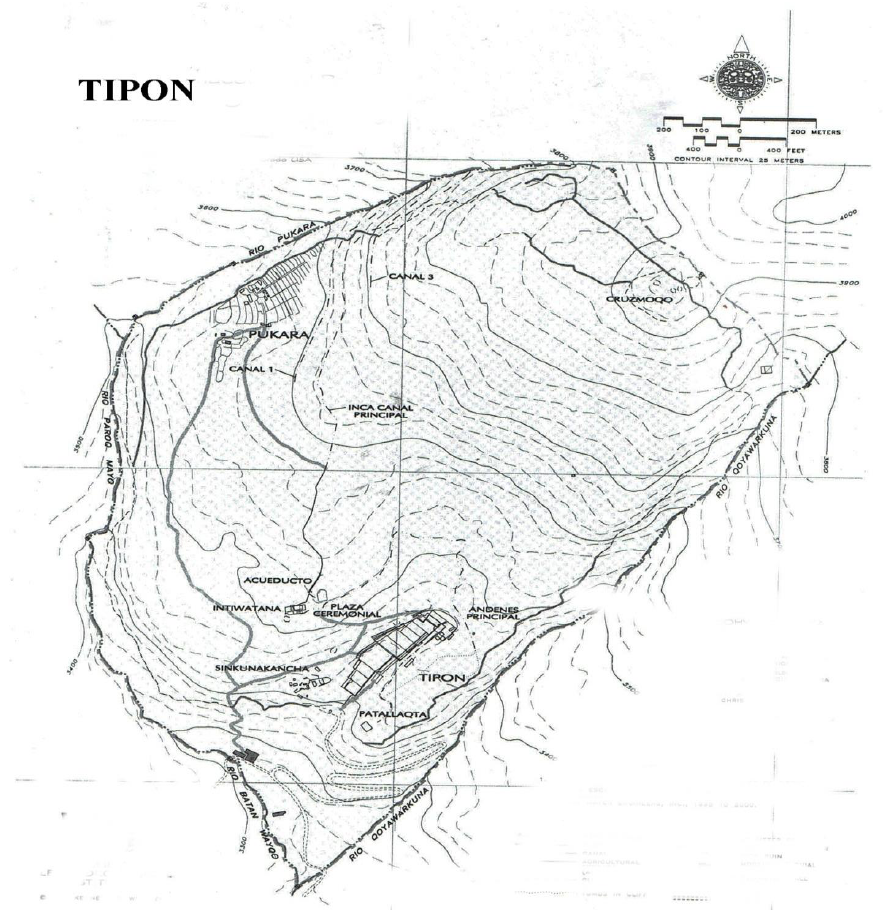
Figure 1. The site of Tipon close to the Inka capital of Cuzco. Note multiple site water channels derived from the northern Rio Pukara through terrace systems at Pukura that supplied Main Aque- duct water directed to the thirteen agricultural terraces. Note the dashed-line easternmost drainage channel east of the agricultural platforms shown in Figure 2 directing water to the Patallaqta area. (Map courtesy of Ken Wright, Wright Water Engineers, Boulder,